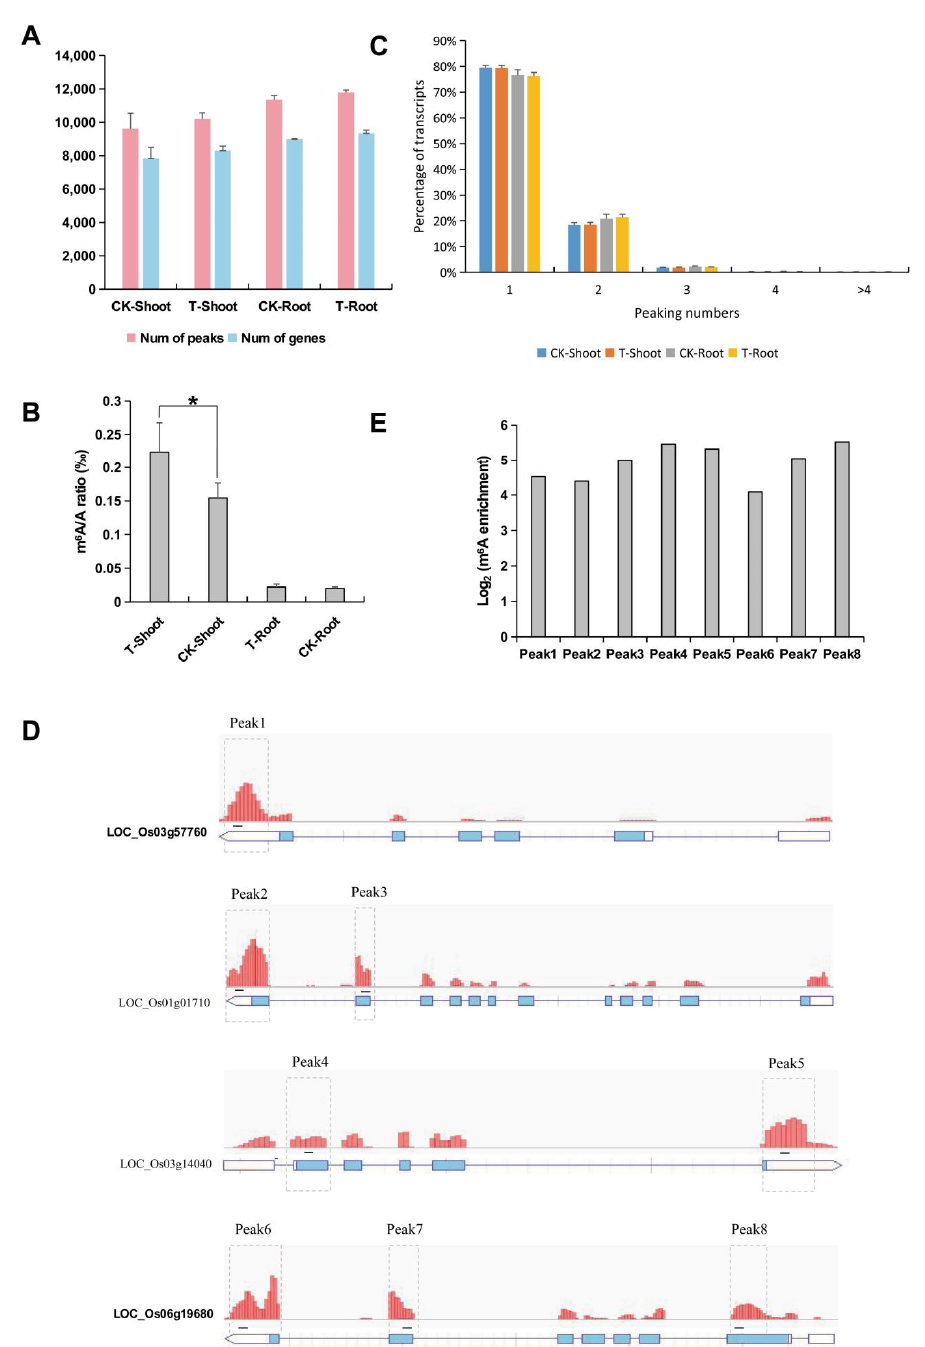
Figure 2. Identification and analysis of m 6 A methylation sites in rice shoots and roots under salt stress (T) and control (CK) conditions. ( A ) Number of m 6 A peaks and m 6 A-modified transcripts in rice shoots and roots under control and salt stress conditions; ( B ) m 6 A levels in the rice shoots and roots under control and salt stress conditions (* p < 0.05; Student’s t -test); ( C ) Proportions of the m 6 A-modified transcripts with one to more than four m6A peaks; ( D ) Examples of m 6 A-modified transcripts containing one m 6 A peak, two m 6 A peaks, and three m 6 A peaks. Rectangles (gray dotted lines) indicate the positions of the m 6 A peaks (peaks 1–8). Black lines indicate the positions of the amplified fragments in the following m 6 A-immunoprecipitation (IP)-qRT-PCR analysis; ( E ) Validation of the m 6 A peaks presented in panel D by m 6